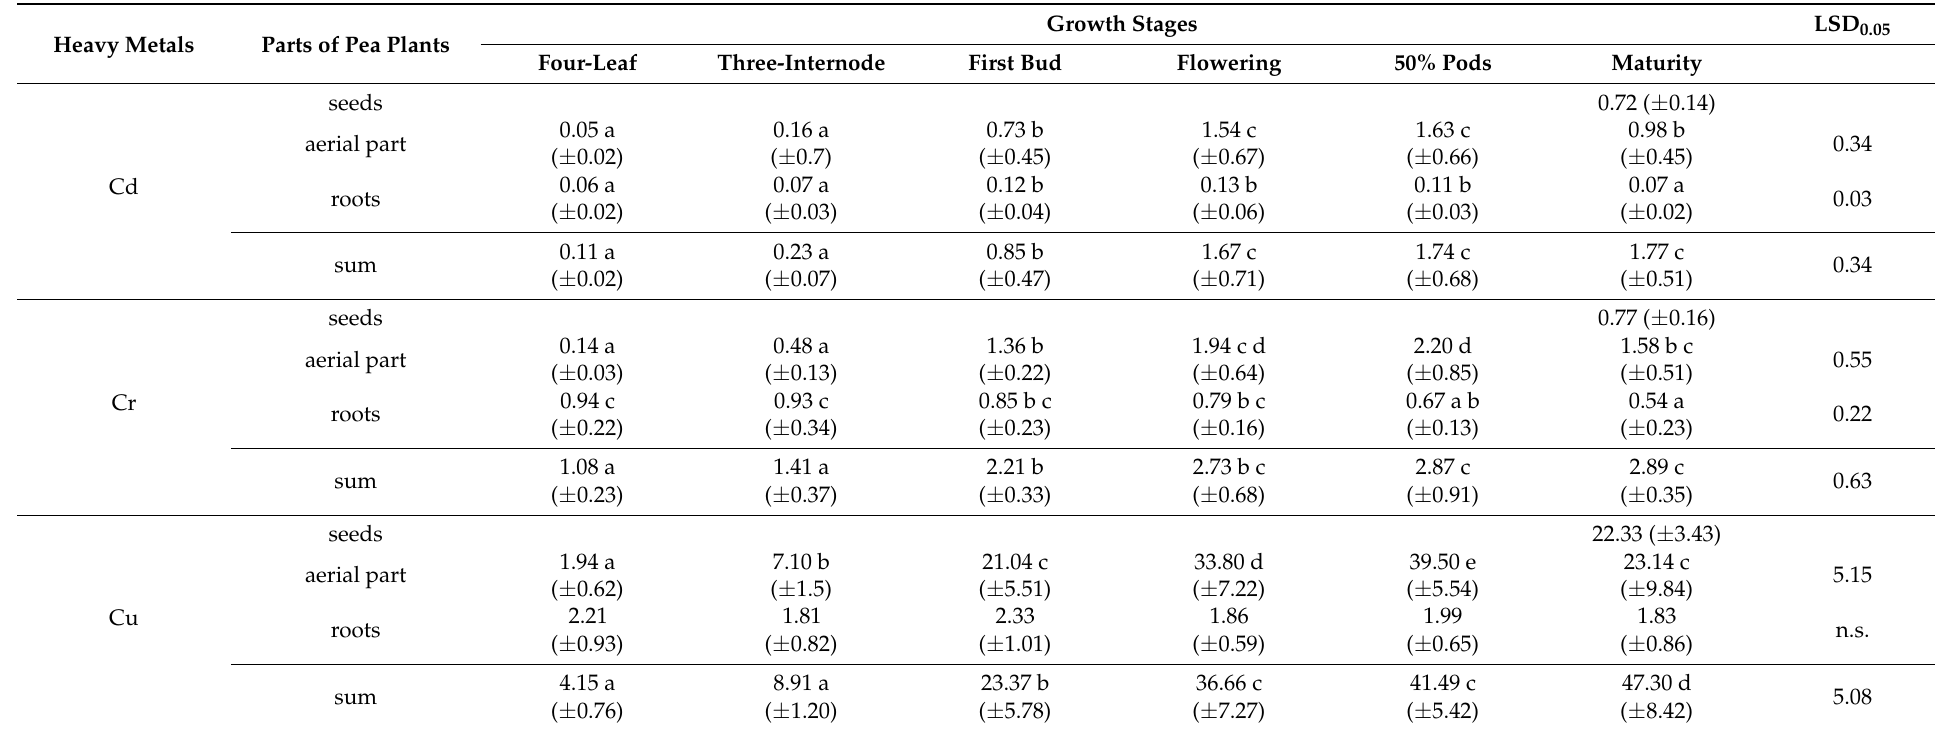
Table 5. HM up by pea plants in successive growth stages, g · ha − 1 (mean values ± SD of two cultivars and two successive years with three repetitions